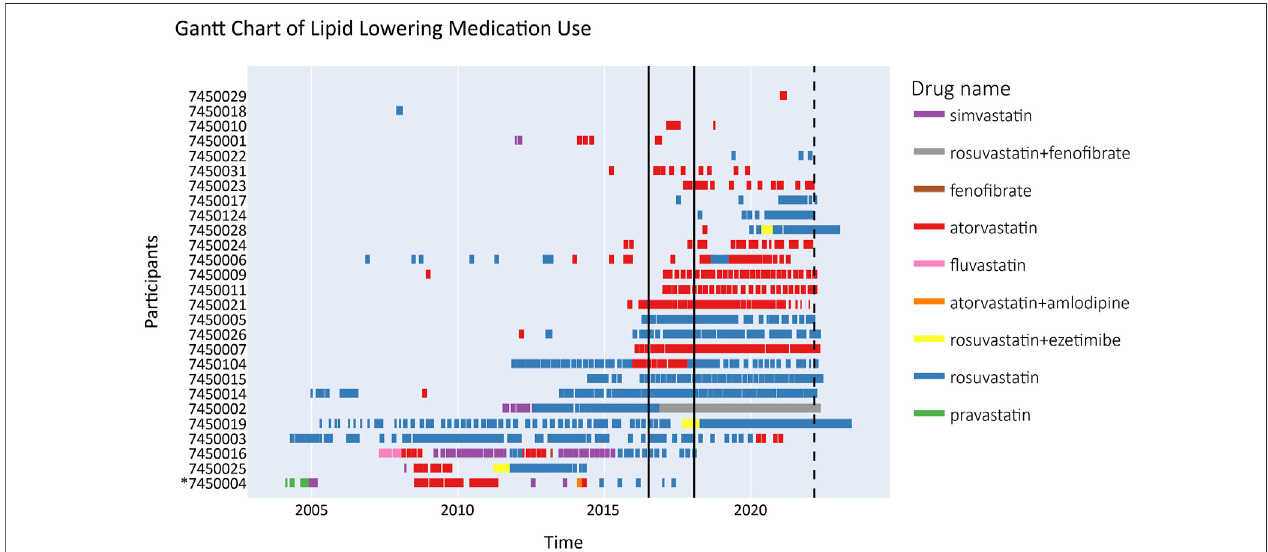
FIGURE 2 | Gantt chart depicting lipid lowering treatment for recalled participants from 2004 until 2022 ( n = 27). The time period between the two solid black lines signi fi es the period of RbG visits (2016 – 2018) in the Alver et al. study. The dashed line signi fi es the end of the drug prescription registry follow-up. The lines crossing the end of follow-up indicate purchase of a signi fi cant stock of medication in advance. Drug name here indicates the active substance of the prescribed LLT, not the brand name. Participant #7450004 passed away in 2018 (denoted by *).